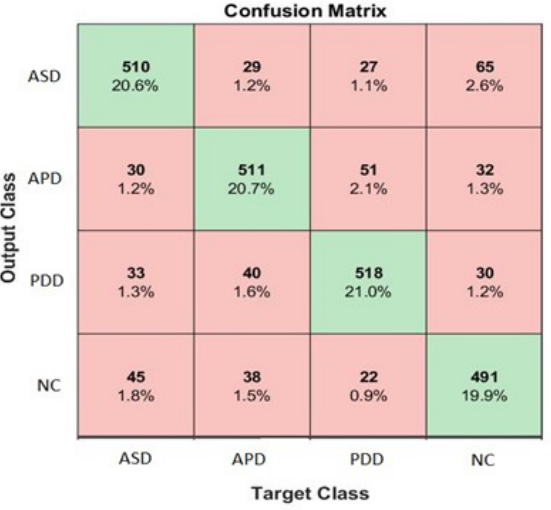
Figure 6. Confusion matrix for classification of WCT images of ASD subtypes and NC using ADAM